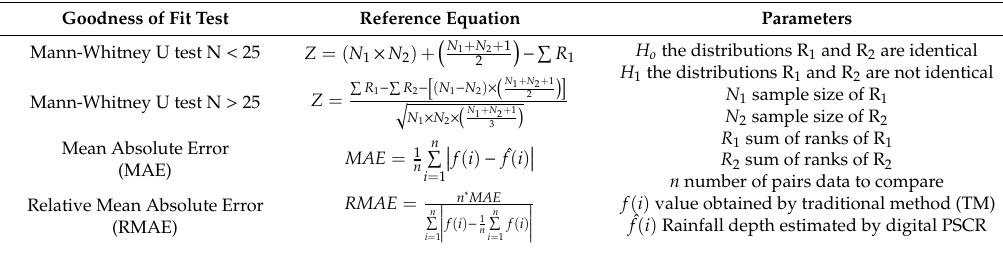
Table 1. Goodness of fit test